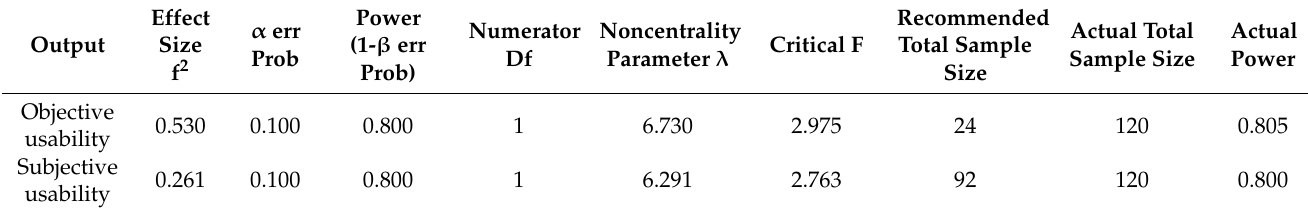
Table 16. Statistical power of two-way ANOVA sample